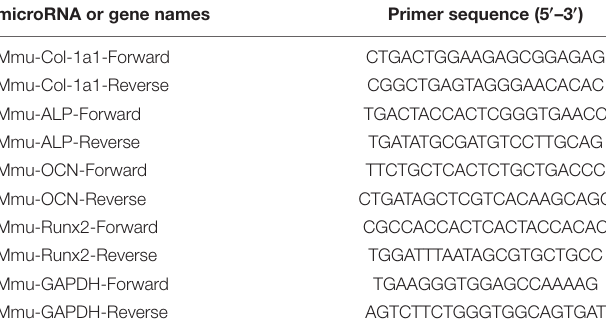
TABLE 1 | mRNA primer